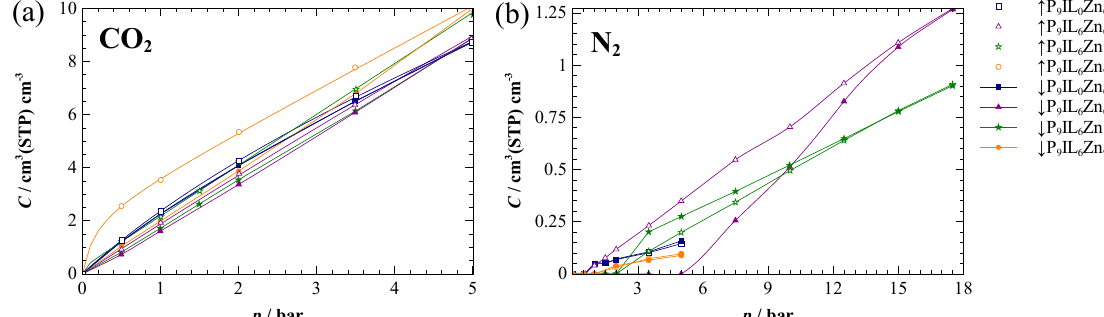
Figure 3. CO 2 ( a ) and N 2 ( b ) sorption isotherms in composites at 20 ◦ C measured directly by gravimetric apparatus. Filled and open symbols denote absorption and desorption runs, respectively. The corresponding coloured solid curves provide guides for the eyes. In the case of ( a ), the curves are fitted with DMM. Table 2. Dual-mode model parameters and separation properties obtained at 20 ◦ C Sample P 9 IL 0 Zn 0 Powder Solid Gel Cube Solid Gel Cube Solid Gel Cube Particle radius ( r v 0.5 ) (eq.) a , µm 25.4